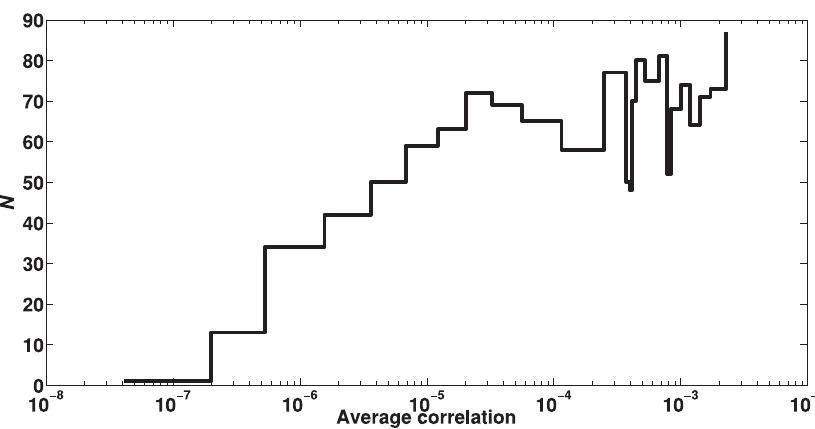
Figure 1. The relation between the results of enrichment analysis and the average correlation C j . The percentage of diseases for which GO/KEGG terms were identified by Saddlesum as a function of average correlation C j . To facilitate the calculation, we sorted all C j s in ascending order and placed them into bins each containing 100 diseases. The percentage is then measured by the number N of diseases with GO/KEGG term hit(s) per bin. For very low average correlations N is significantly lower.